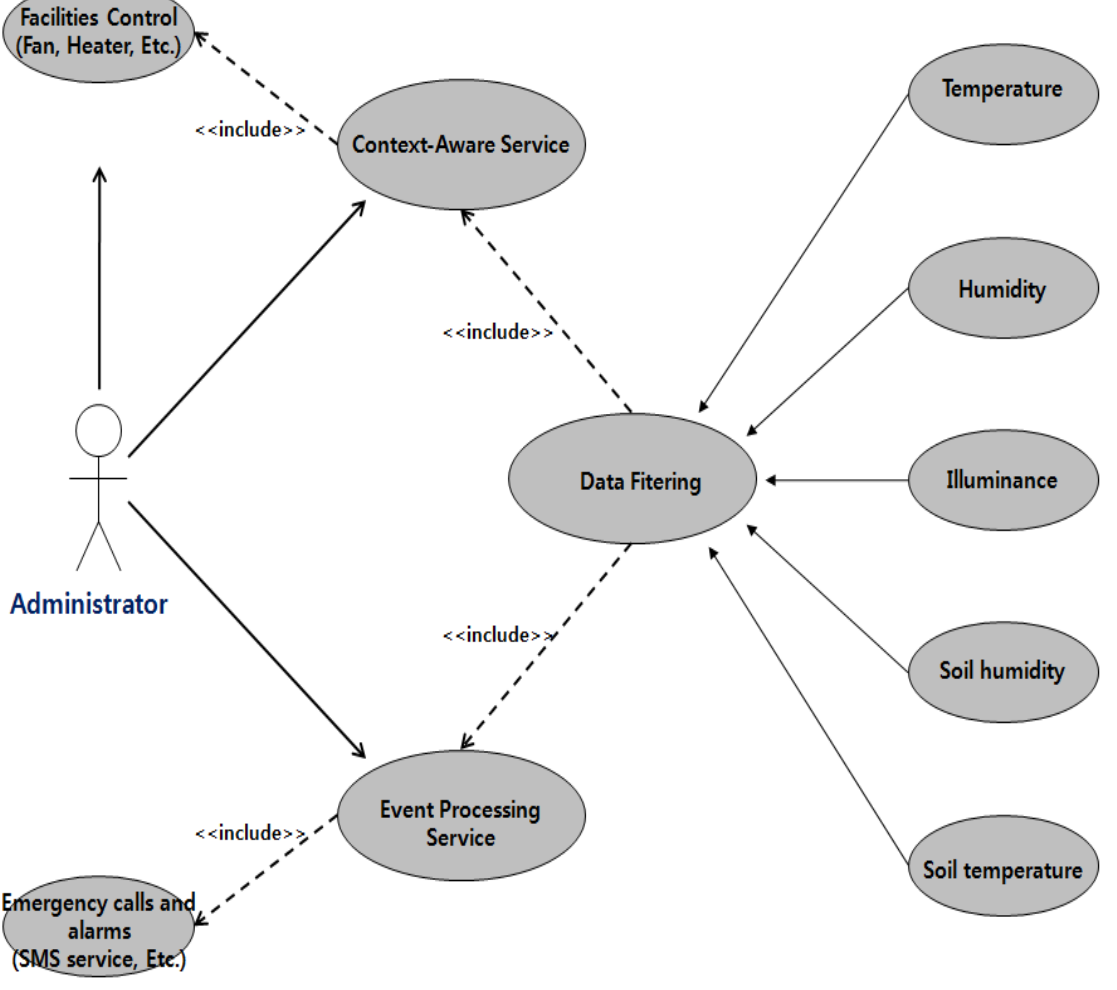
Figure 6. Use case diagram of the ubiquitous greenhouse